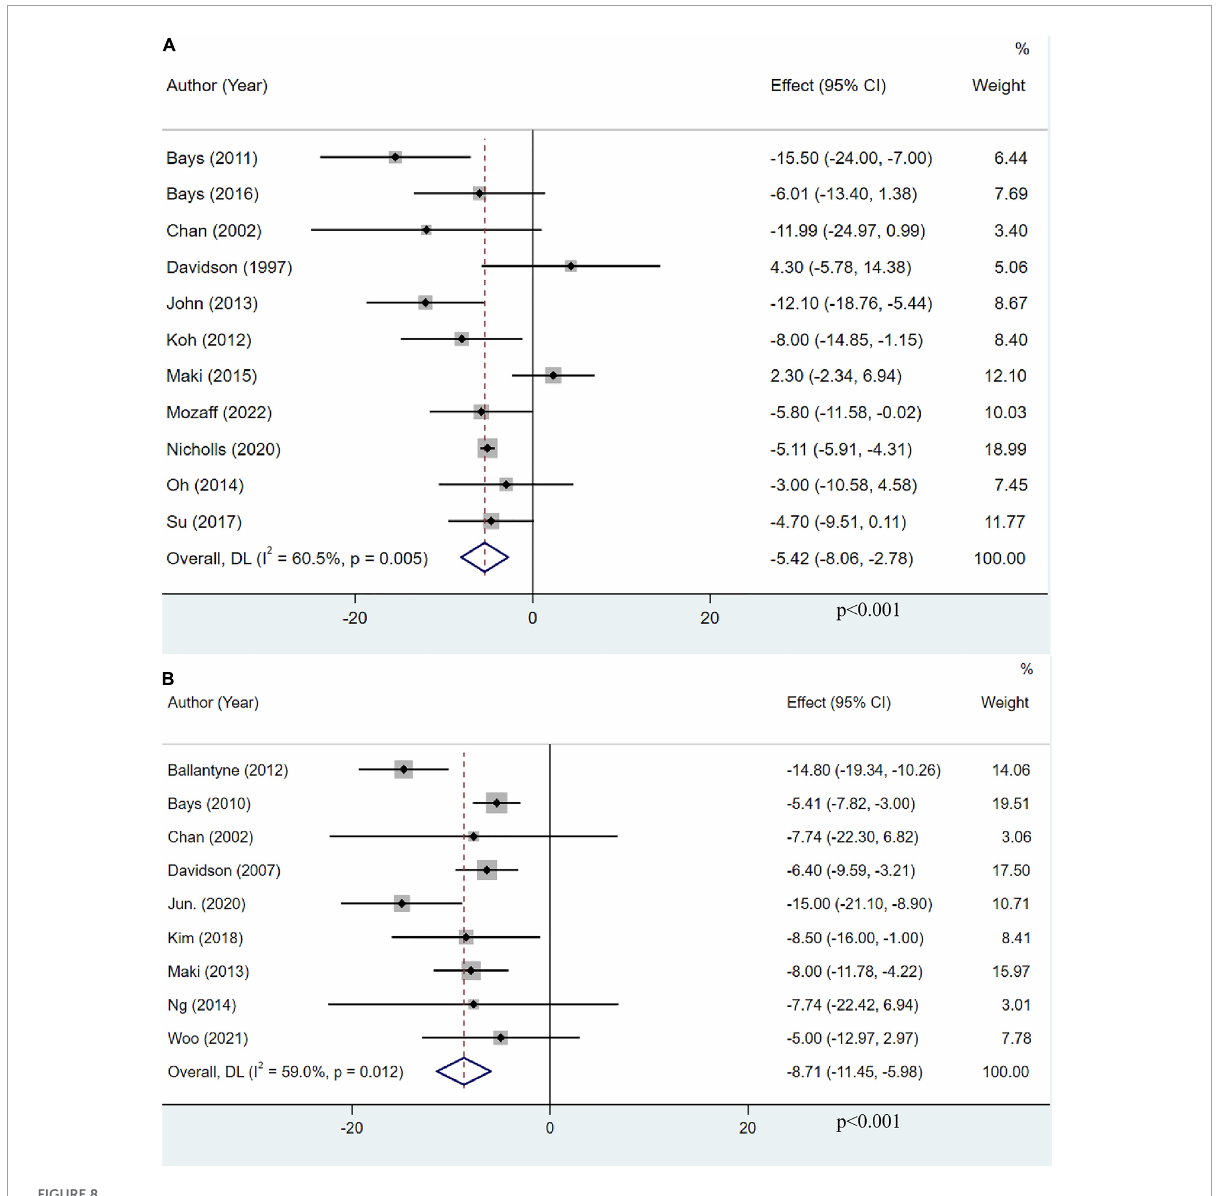
FIGURE8 The effect of OM3-FA on non-HDL-C. (A) OM3-FA monotherapy; (B) Combined therapy of statins plus OM3-FA.